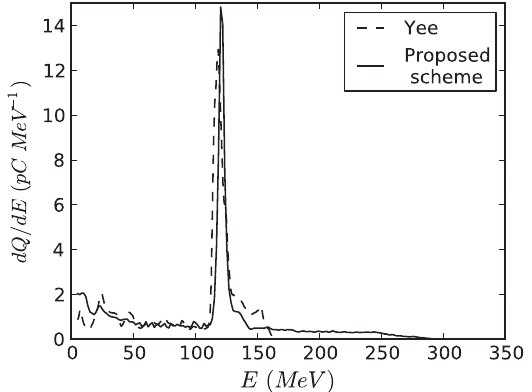
FIG. 10. Energy spectrum after 300 (cid:2) m of acceleration (from the position when injection started) for the two numerical schemes considered